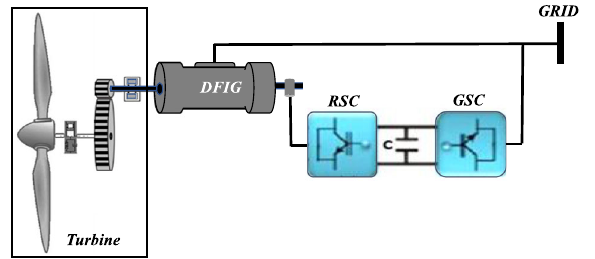
Fig. 3 Wind turbine drive